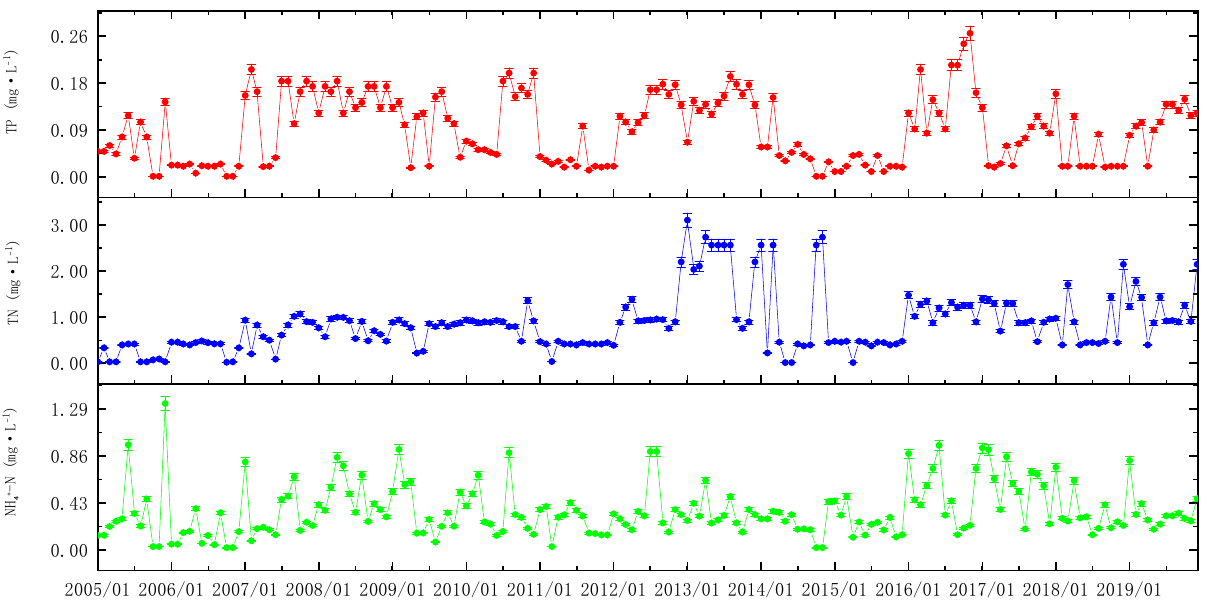
Figure 2. Changes in N and P nutrients in the River Yi from 2005 to 2019 (means ± SD). The TN content of the water body changed in a relatively constant manner. With time, there was an overall increased tendency in TN content. The TN content in the water body increased noticeably between December 2012 and November 2014. Since 2016, the TN content has demonstrated a strong upward trend, ranging from 0.40 to 2.15 mg · L − 1 (Figure 2). The TN in 2005 and 2006 was significantly lower than that in the other years ( p <